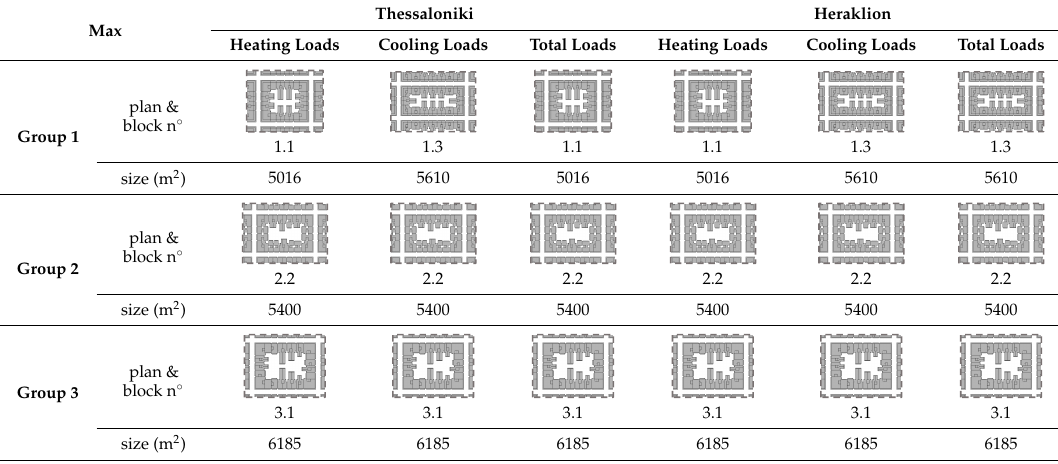
Table 8. Correlation of the form parameters to the load demand of the urban blocks of group 1 for the climate of Thessaloniki.